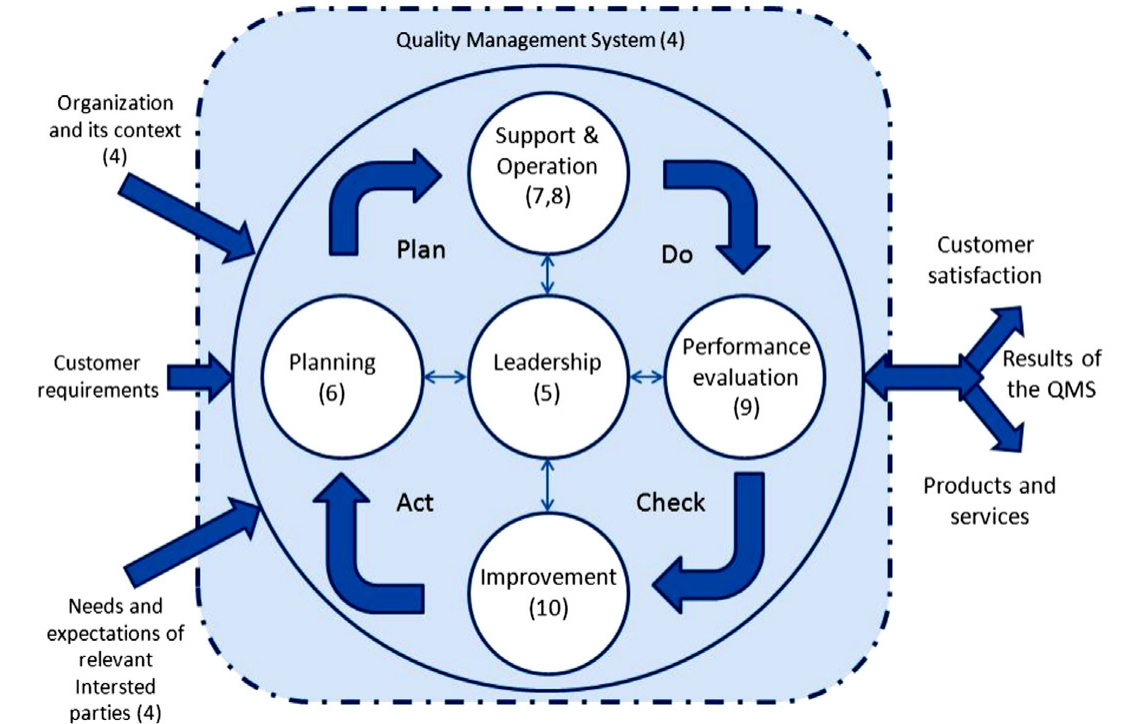
Fig. 1: Structure of ISO 9001:2015 in PDCA cycle (ISO 9001:2015 Quality Management System Standard, 2015)